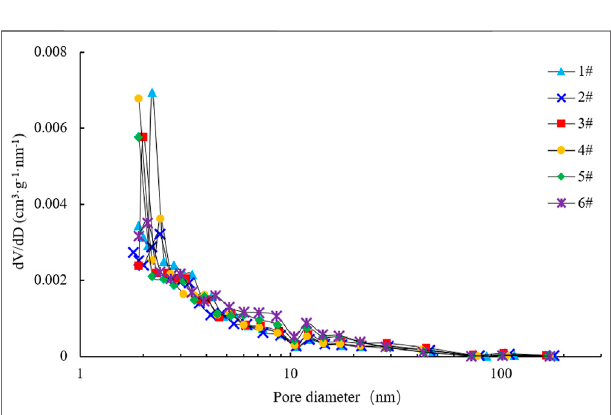
FIGURE 6 | Pore size distribution characteristics of different